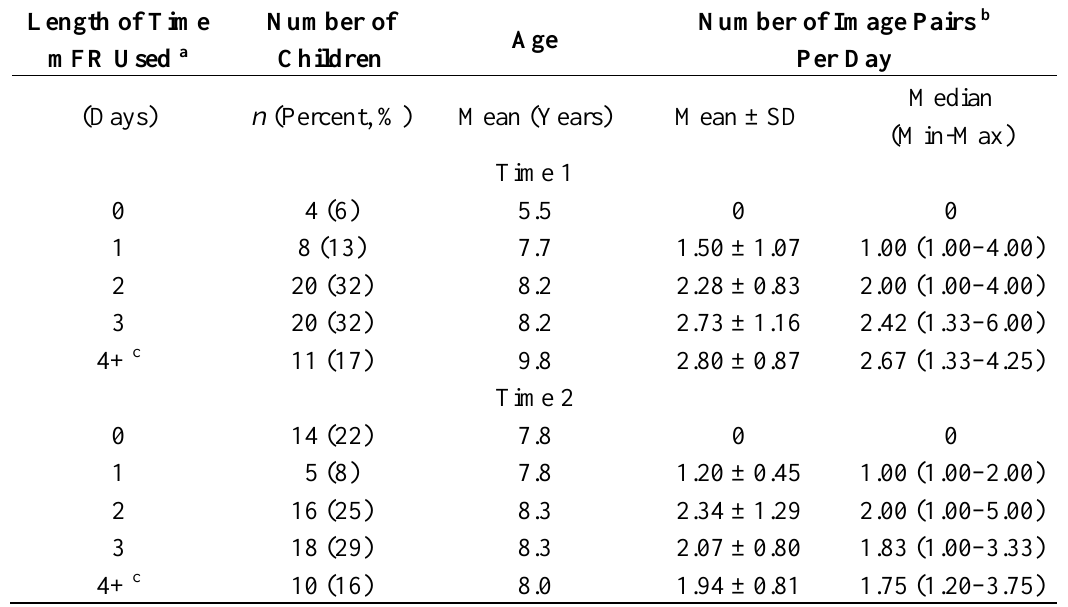
Table 4. Descriptive data of images captured using the mobile food record (mFR)